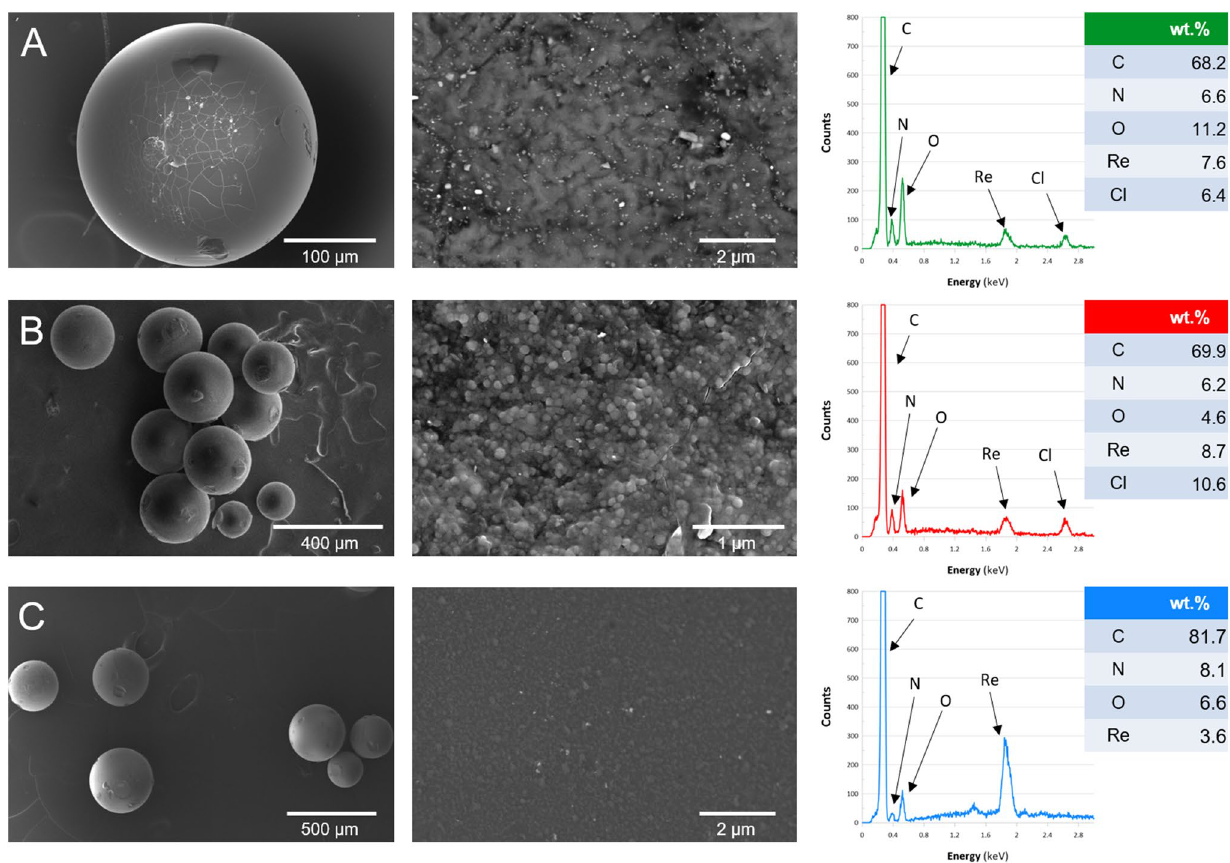
Figure 3. SEM photomicrographs and EDX spectra of ( A ) Re@HEP, ( B ) Re@BAPP, and ( C ) Re@CIM samples. The elemental composition is an average value obtained from 3 EDX micro elemental